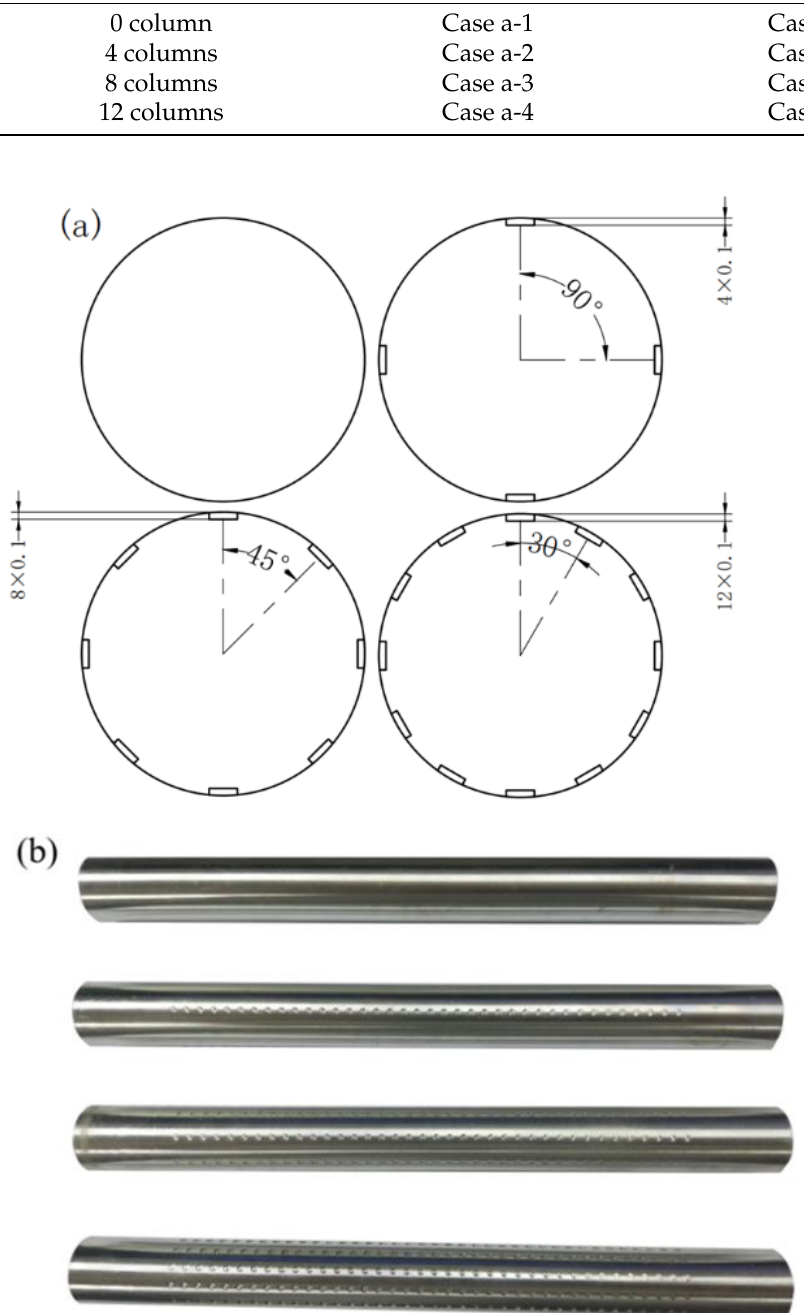
Figure 8. Experimental cylinder: ( a ) cylinder size; ( b ) finished product.